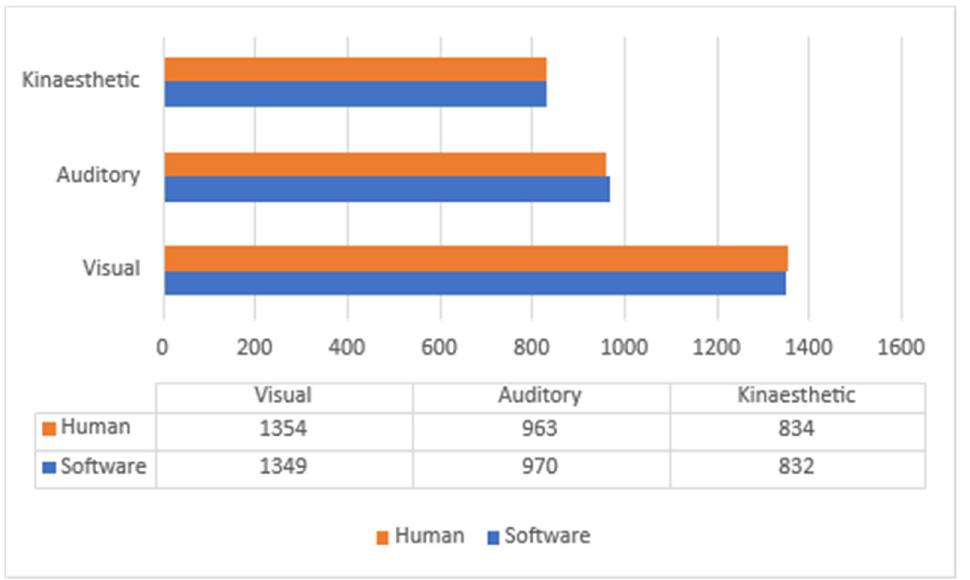
Figure 3. Comparing the number of preferred representational systems identified by human experts and software. Table 3. Comparing the performance of the human experts and the